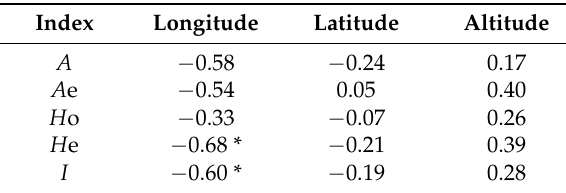
Table 5. Correlation between genetic diversity index and geographical